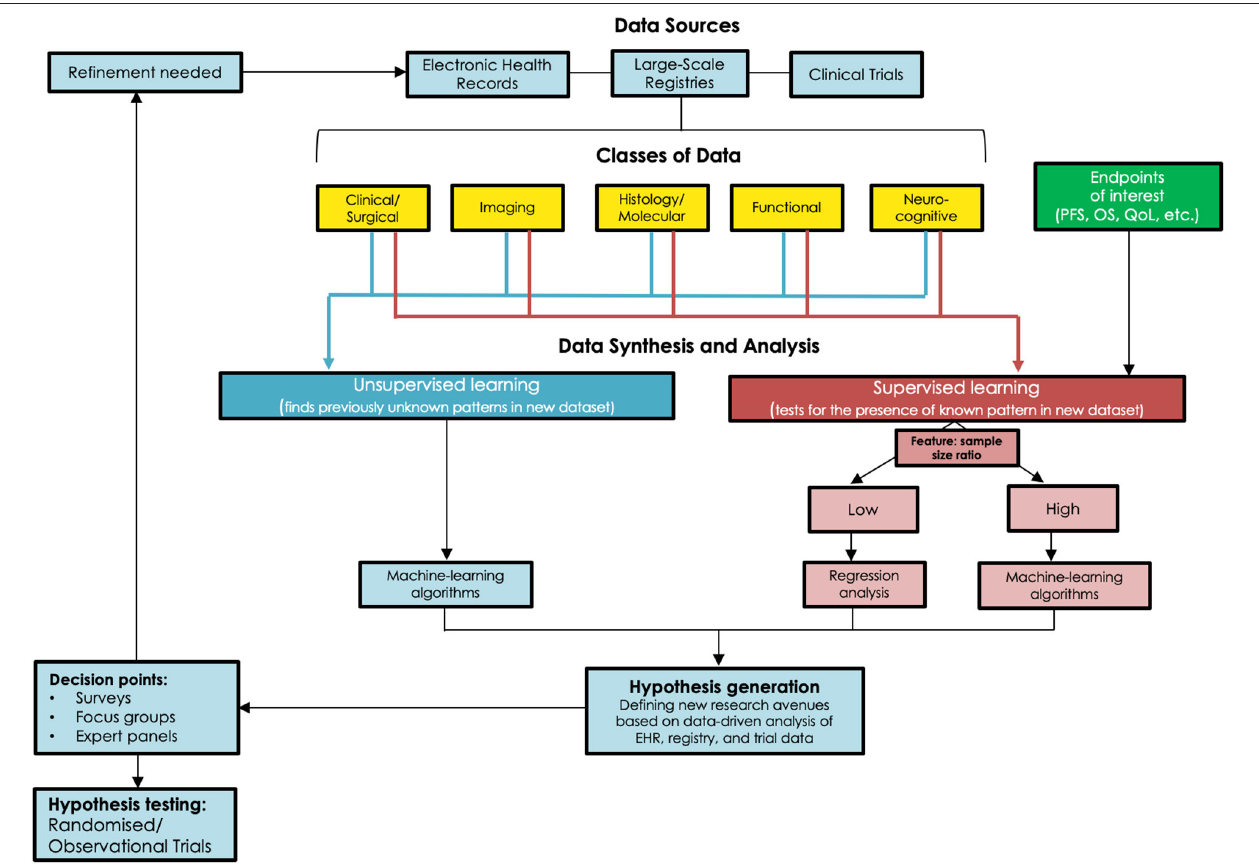
FIGURE 1 | Schematic outlining the various strategies to acquire new data in the management of DLGGs and generate hypotheses for further research, and the need for observational or randomized trials to validate these